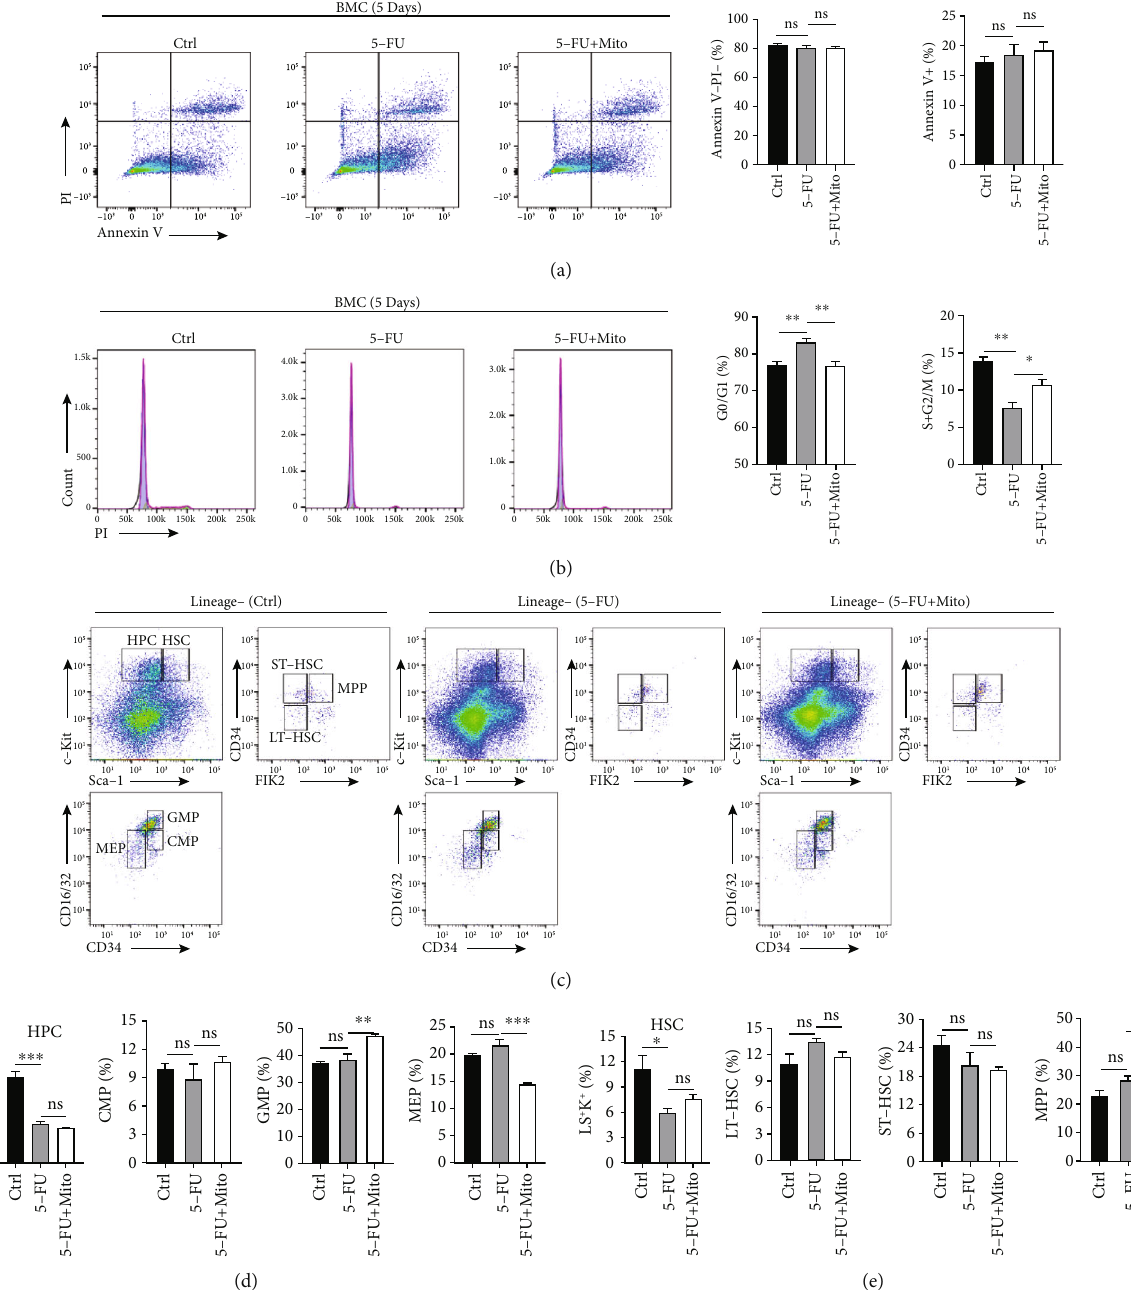
Figure 6: Analysis of hematopoietic regulatory function of BA-MSCs treated with platelet-derived mitochondria after 5-FU chemotherapy. (a) Flow cytometry analysis of apoptosis of BMCs cocultured with BA-MSCs for 5 days. (b) Flow cytometry analysis of cell cycle of BMCs cocultured with BA-MSCs for 5 days. (c) Flow cytometric plots of BMCs cocultured with DMSO-treated BA-MSCs, 5-FU-treated BA-MSCs, and mitochondria-treated 5-FU-damaged BA-MSCs for 2 days. Flow cytometric plots are gated on lineage-negative BMCs and showing cell subsets of HPC, HSC, LT-HSC, ST-HSC, MPP, CMP, GMP, and MEP. (d, e) Flow cytometry analysis of percentage of HPC, HSC, LT-HSC, ST-HSC, MPP, CMP, GMP, and MEP cell subsets ( n = 3 ). Control group: BA-MSCs were treated with DMSO for 48h. 5-FU group: BA- MSCs were treated with 5-FU for 48 h. 5-FU + Mito group: BA-MSCs were treated with 5-FU for 48h and incubated with platelet- derived mitochondria for 24 h. All data are presented as mean ± SEM . Statistics: one-way ANOVA (ns: not signi fi cant; ∗ p < 0 : 05 , ∗∗ p < 0 : 01 , and ∗∗∗ p < 0 : 001